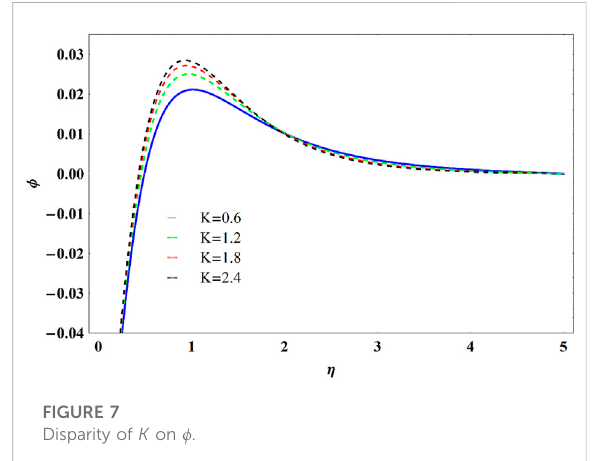
FIGURE 4 Disparity of M on ϕ .